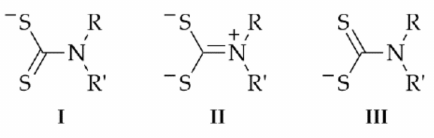
Figure 1. Canonical forms of dithiocarbamate, RR (cid:48) NCS 2 − , R/R (cid:48) = H, alkyl and aryl. The versatility of dithiocarbamate ligands stems from the near equal contributions of the two resonance forms, I and III (2 × 30%) and II (40%) (Figure 1). This is also